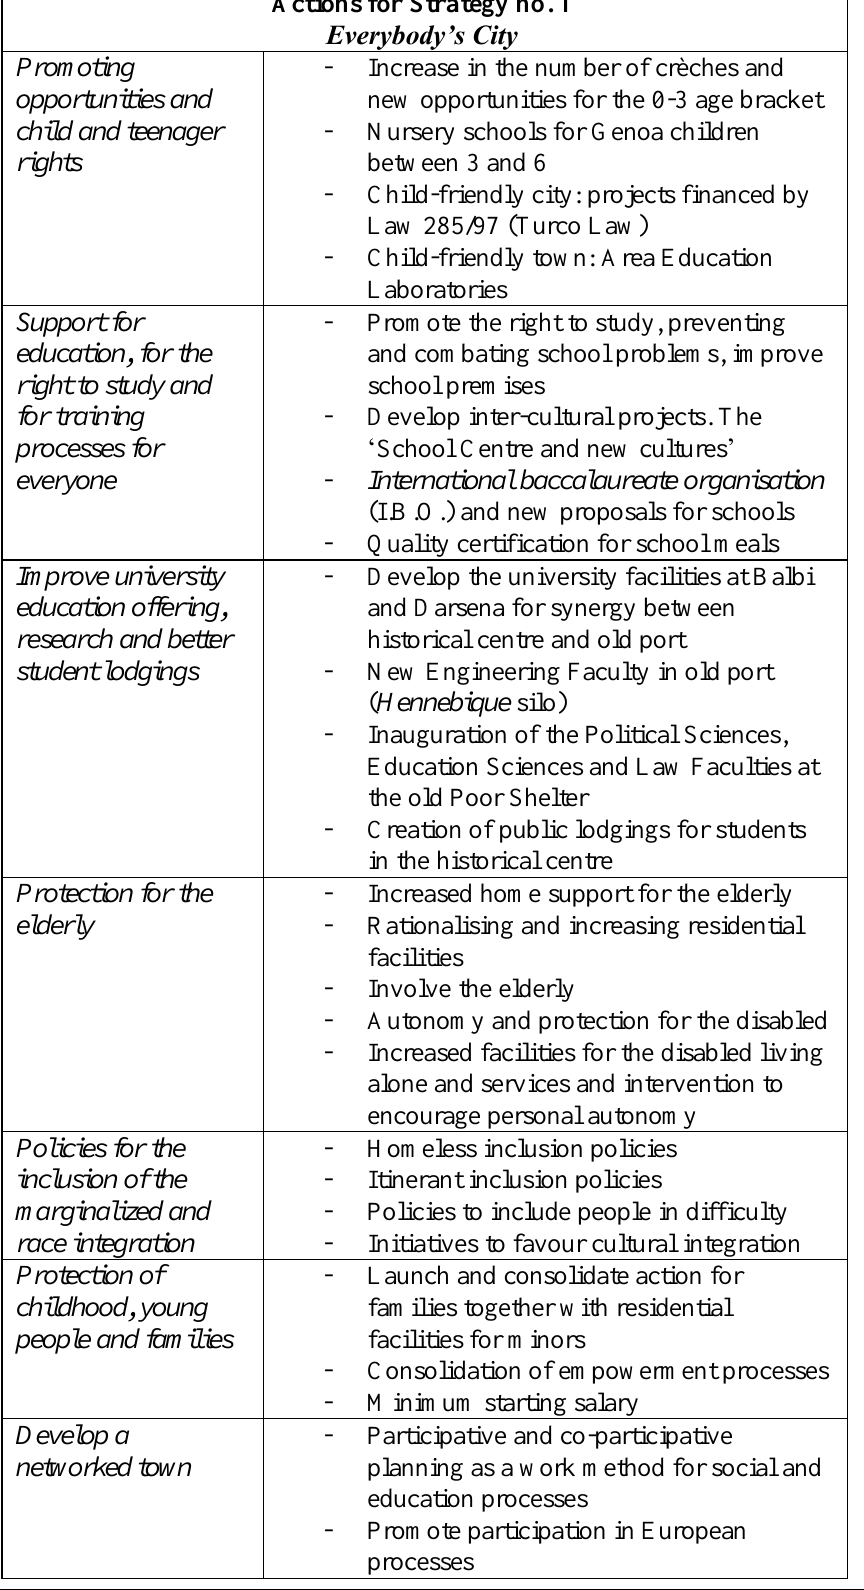
Figure 2 : 2002 City Plan: an Example of the Link Between Strategies, Targets and Actions